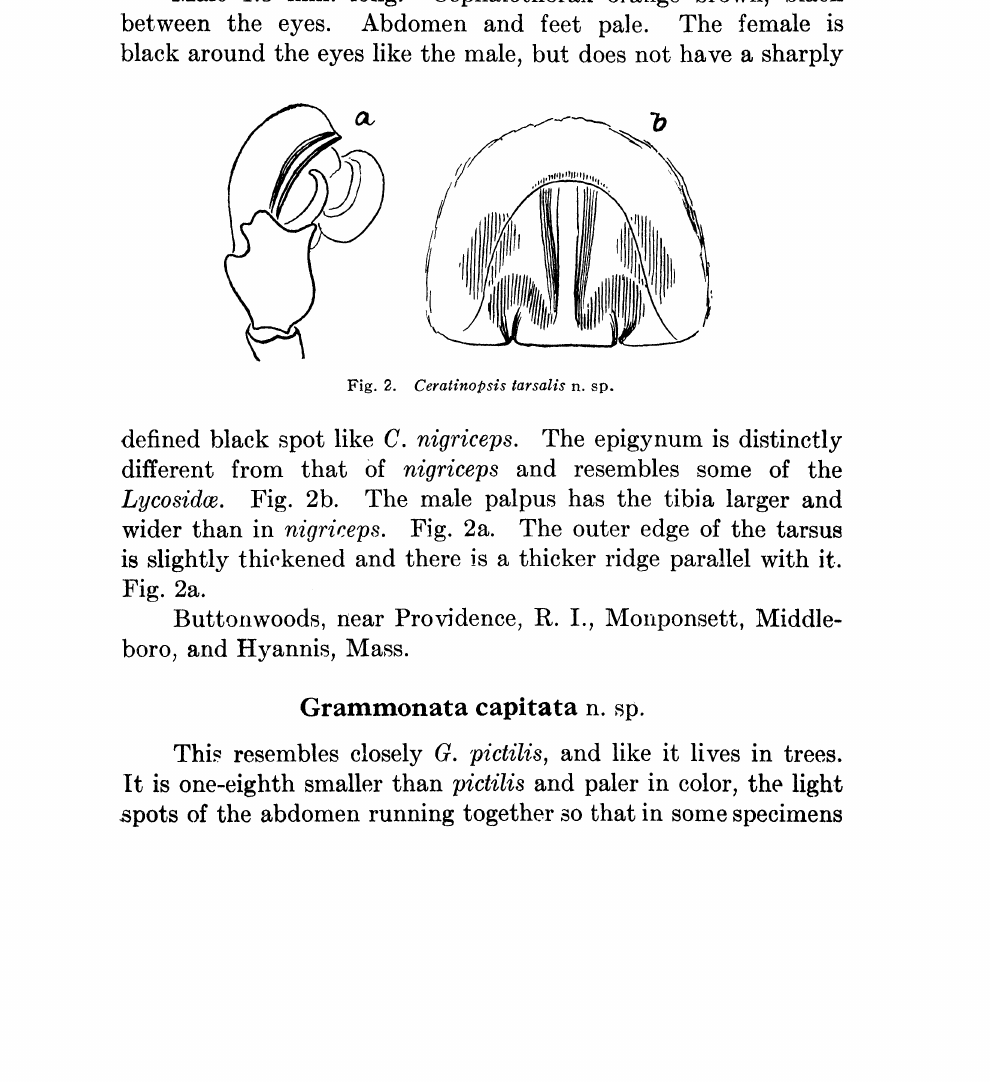
Fig. 1, b. The legs are